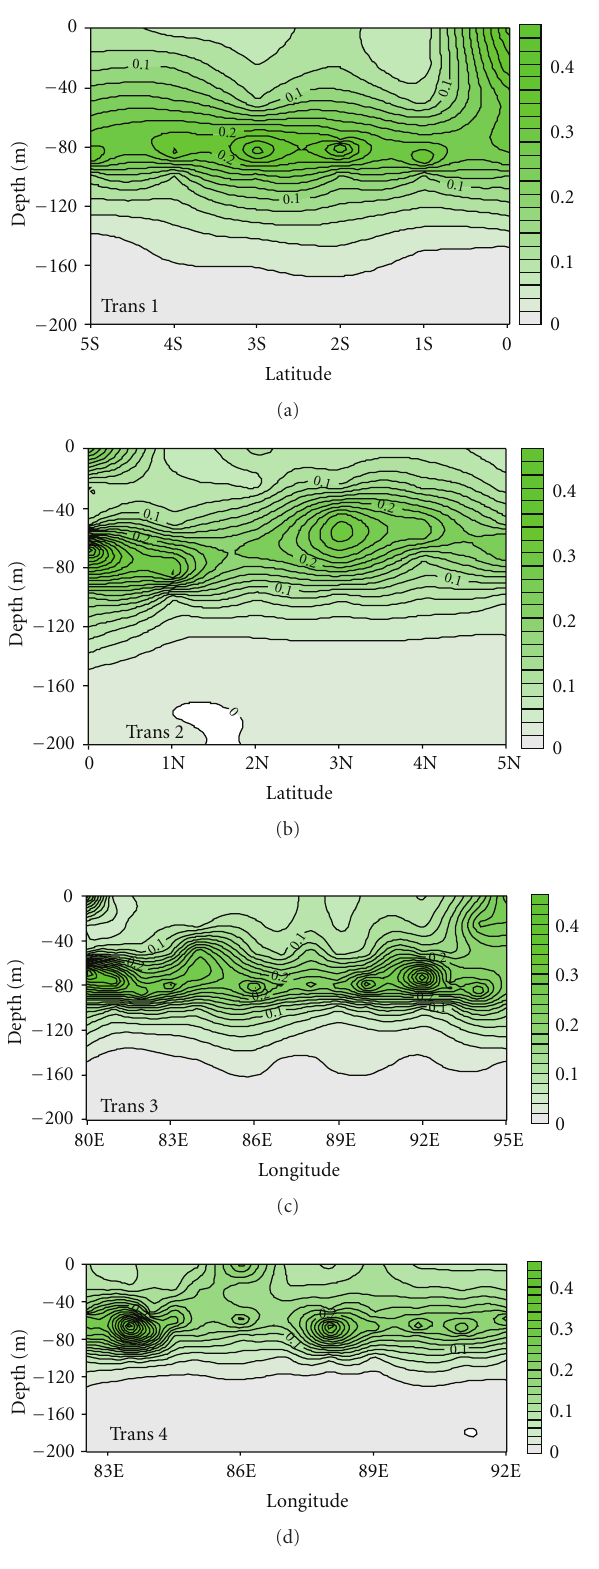
Figure 2: Vertical patterns of chlorophyll a concentration (Chl a , µ g L − 1 ) along the four transacts, showing the variations in the latitudinal ((a) and (b)) and longitudinal ((c) and (d)) scales.